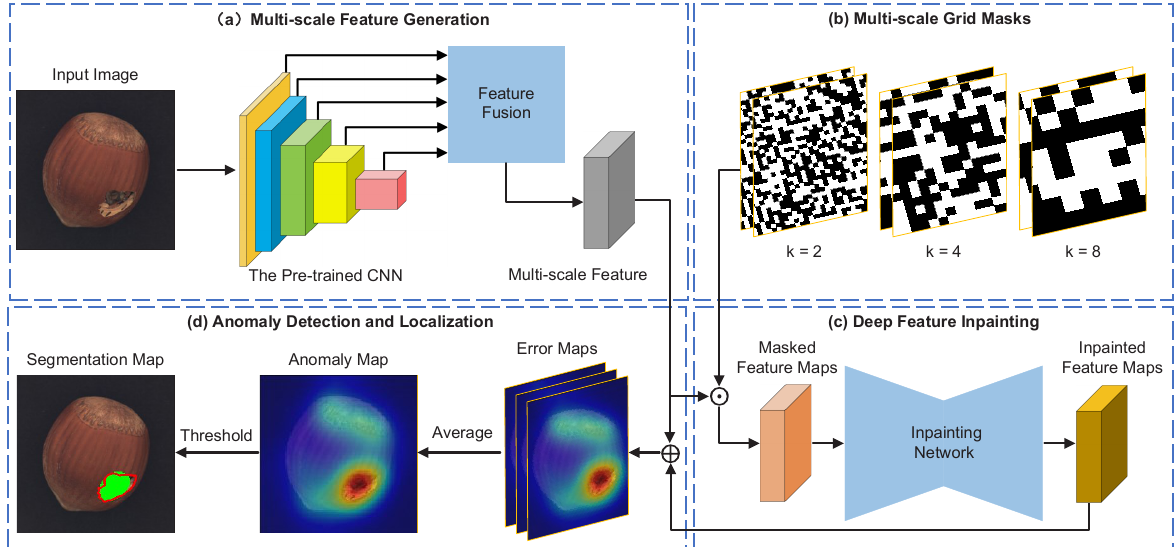
Figure 1. The overview of the multi-scale feature inpainting (MSFI). It consists of four parts: multi- scale feature generation, multi-scale grid masks, deep feature inpainting and anomaly detection and